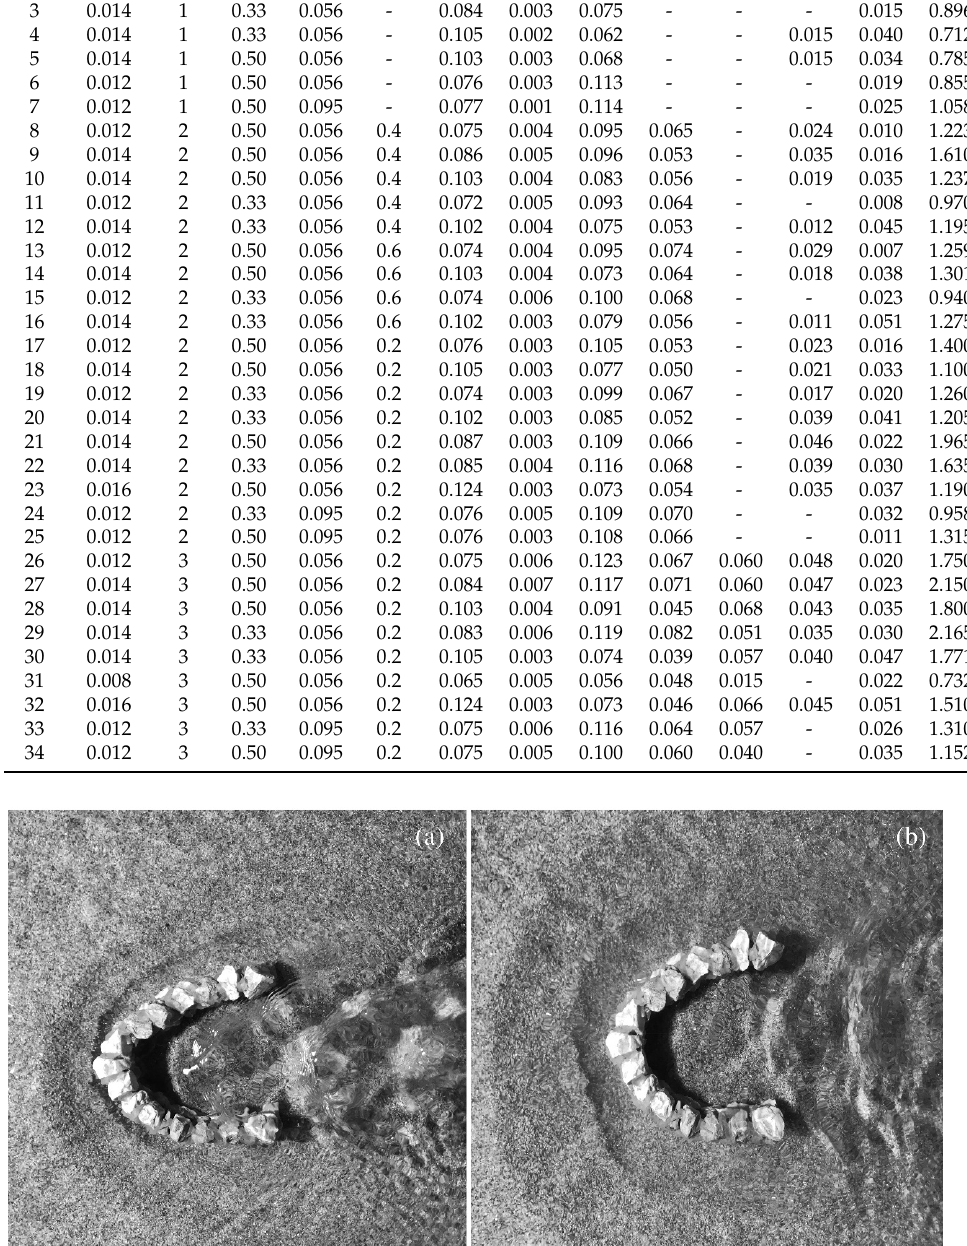
Table 1. Summary of experimental conditions and results.